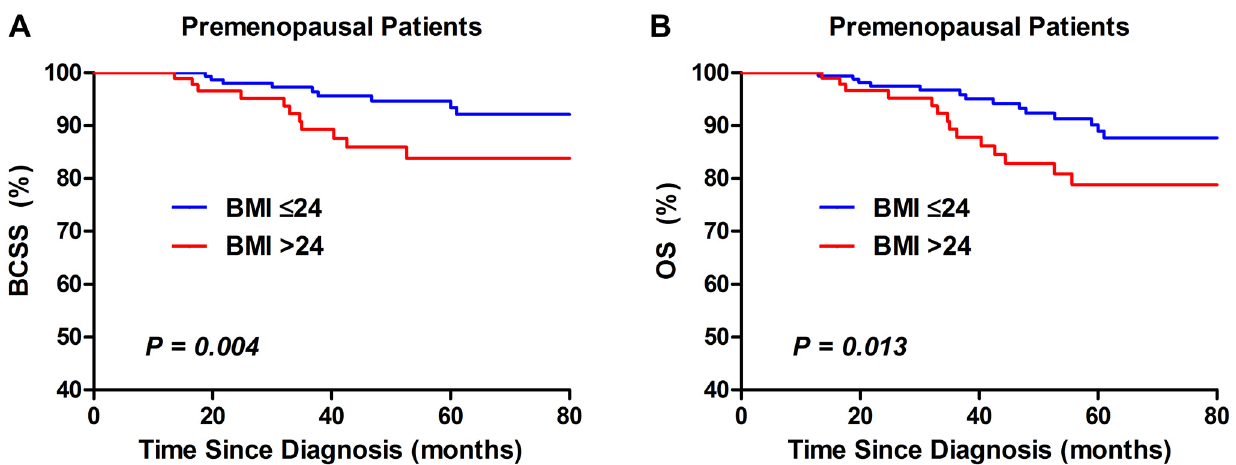
Fig 2. Kaplan – Meier curves of BCSS (A) and OS (B) by BMI groups in premenopausal TNBC patients.